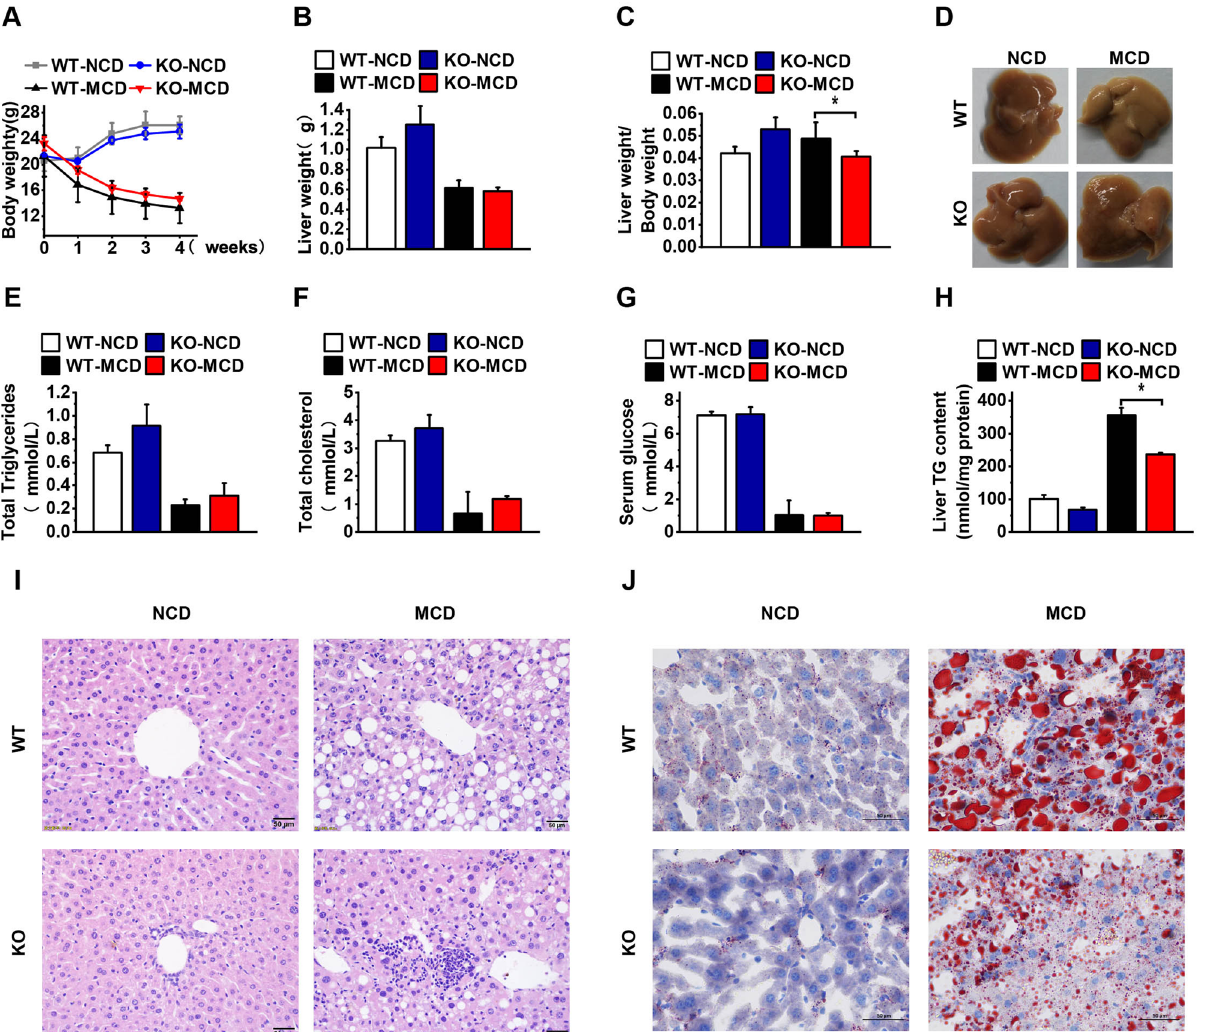
Figure 2. Osteoprotegerin (OPG) deficiency reduced methionine- and choline-deficient (MCD) diet-induced hepatic steatosis. ( A ) The body weight of the WT or OPG KO mice after MCD diet 1–4 weeks. ( B ) Liver weight of the mice. ( C ) Liver weight to body weight ratio. ( D ) Gross photograph of the mice’s liver. ( E ) Serum triglyceride levels. ( F ) Total serum cholesterol. ( G ) Serum glucose. ( H ) Triglyceride levels in the liver. ( I ) The representative image of hematoxylin–eosin staining. ( J ) The representative image of Oil Red O staining. The scale bar is 50 µm. Each group at least has 3 samples. The data in ( A – C ), ( E – H ) are presented as the mean ± SD, *p <